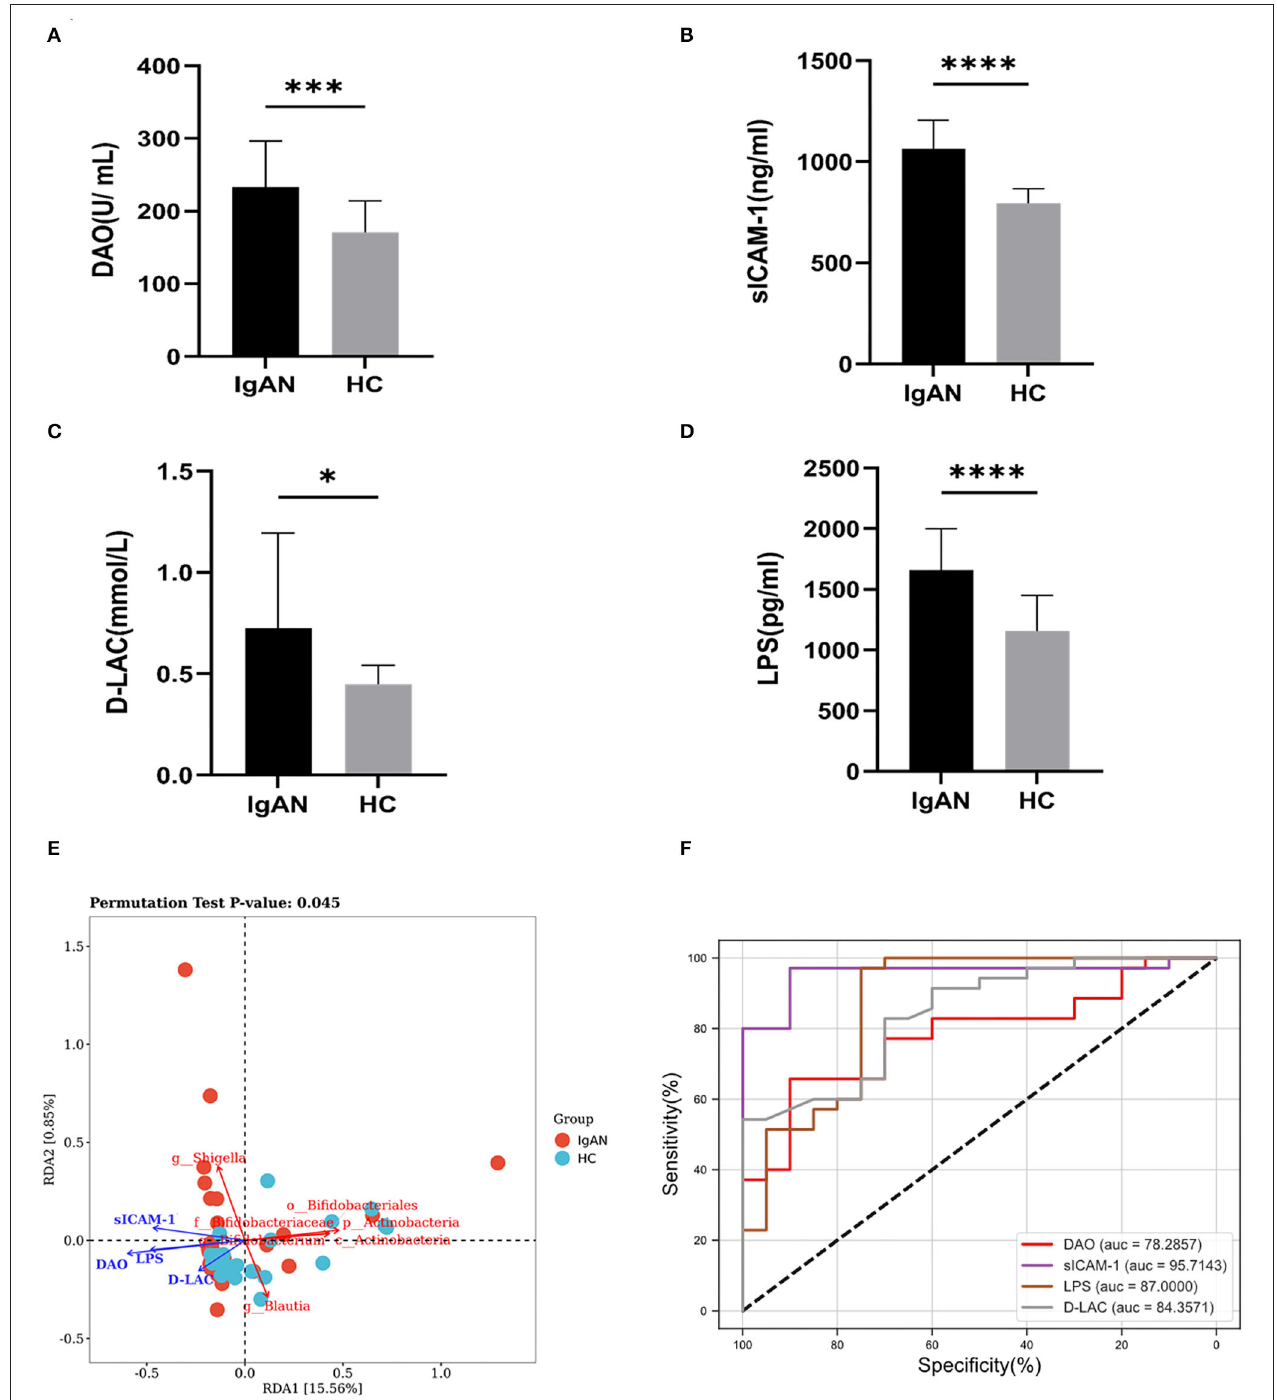
FIGURE 6 | Intestinal mucosal barrier injury indexes. The levels of intestinal barrier injury indicators: DAO, sICAM-1, D-LAC, and LPS in peripheral blood were assayed. The levels of DAO (A) , sICAM-1 (B) , D-LAC (C) , and LPS (D) were significantly higher in patients with IgAN compared to healthy and disease controls (* P < 0.05, *** P < 0.001, **** P < 0.0001). (E) Redundancy analysis (RDA) was constructed to detect the correlation between intestinal barrier function and gut microbiota. (F) ROC curve of the levels of intestinal barrier injury indicators in the exploration cohort with P < 0.05.